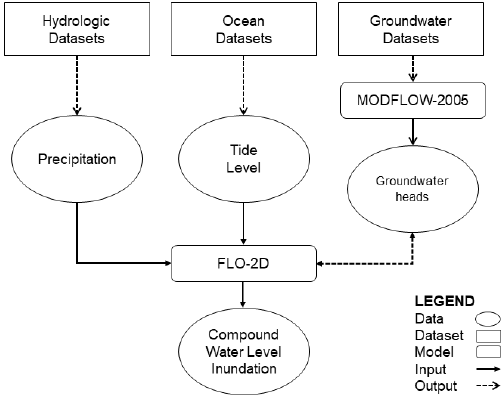
Figure 7. Flowchart representing the CF simulation using FLO-2D as the base hydraulic model. The hydrologic, ocean and groundwa- ter datasets were obtained through observations. The surface hy- drology was incorporated as rainfall and coastal boundary con- ditions in FLO-2D. The groundwater heads were calculated in MODFLOW-2005 and transferred in an iterative manner to FLO- 2D every time a MODFLOW-2005 time step is reached (Fig. 6). Adapted from Santiago-Collazo et al.